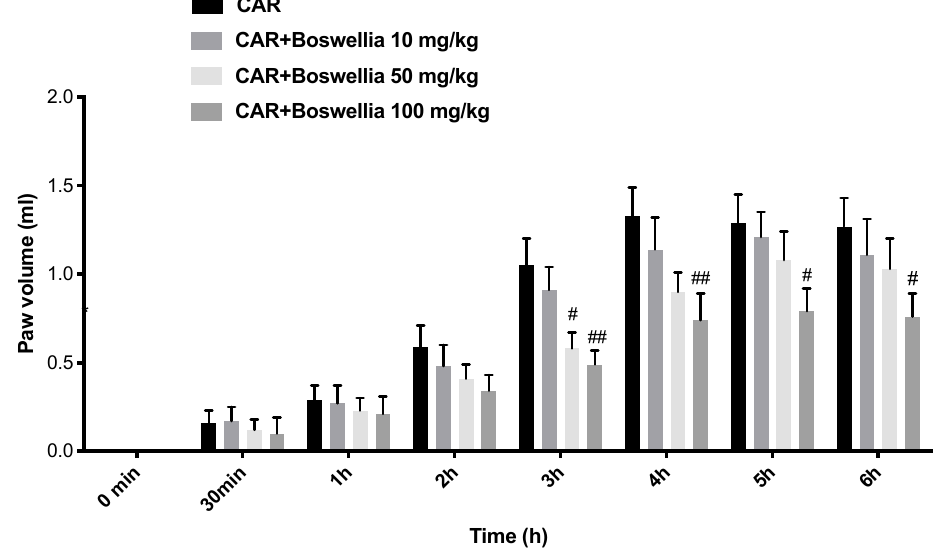
Figure 1. Preliminary data of anti-inflammatory effects of Boswellia extract at different doses 10, 50, and 100 mg/kg. Values are means ± SEM of 6 animals for each group; ## p < 0.01 vs. CAR. # p < 0.05 vs. CAR.